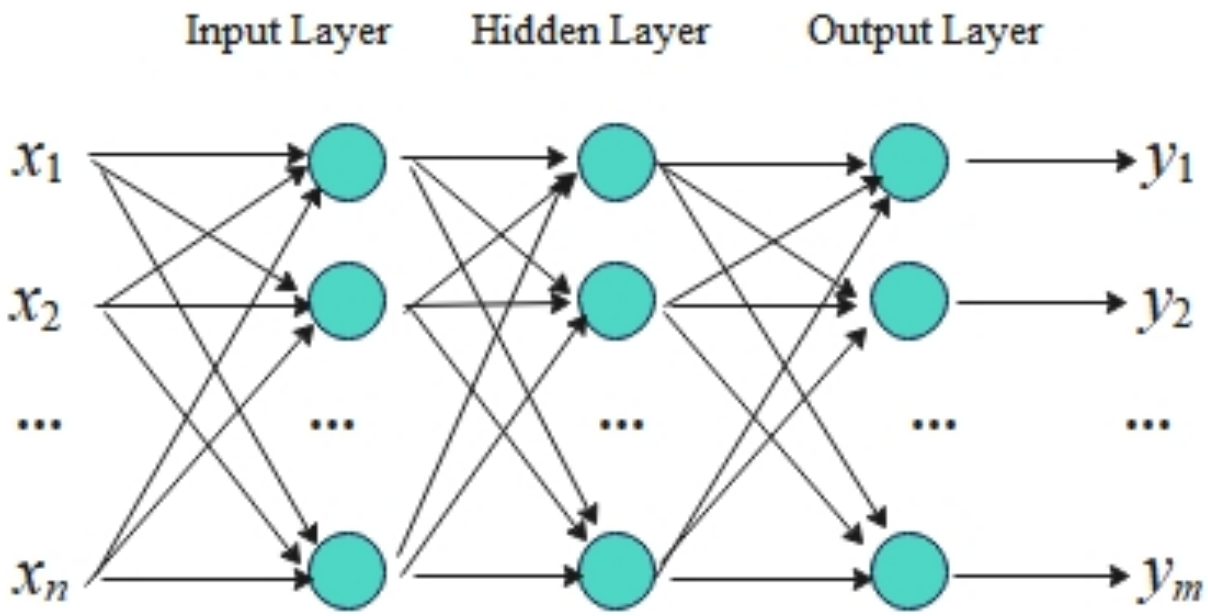
Figure 2. Three layers topological structure of BP neural network.